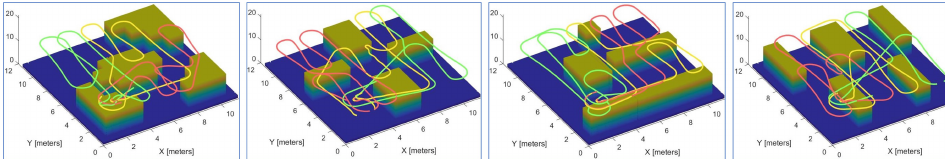
Figure 18. UAV simulated paths of EDM with three robots.